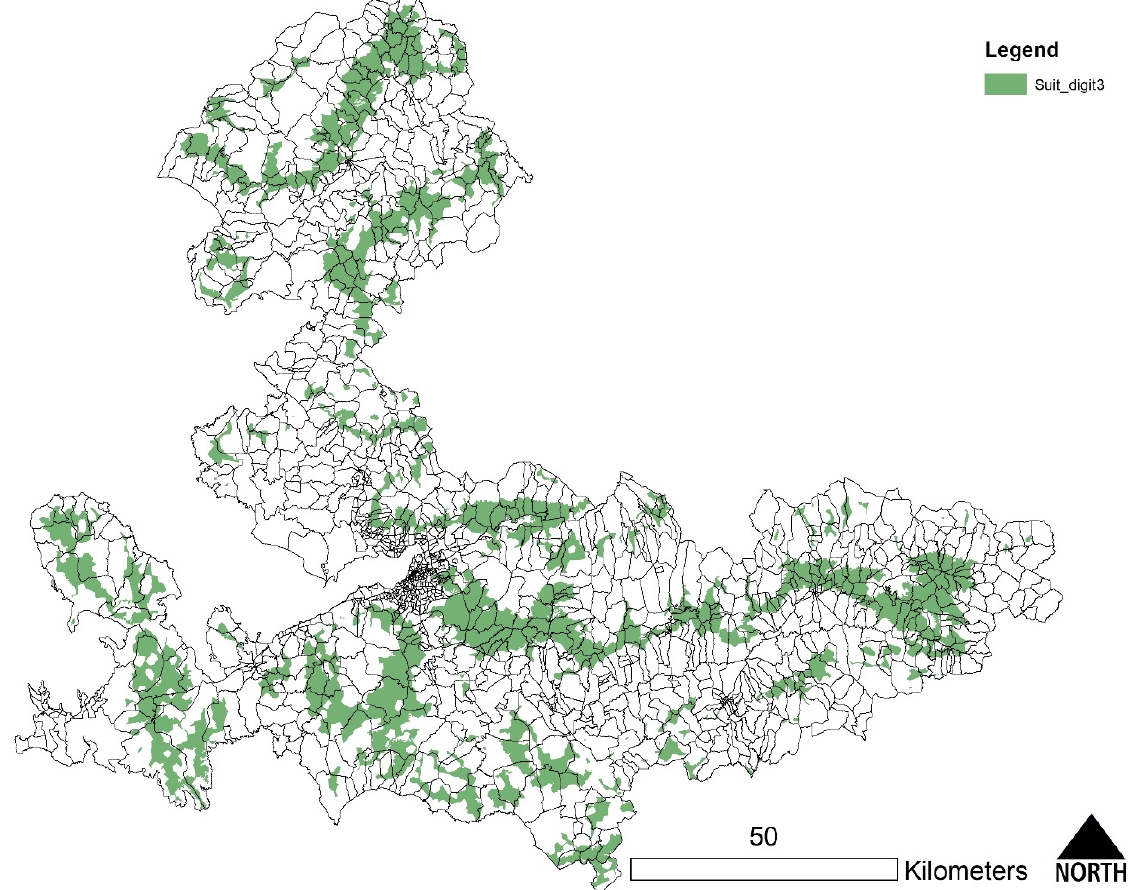
Figure 6. Rendering of the final vector layer. Source: author’s elaboration.